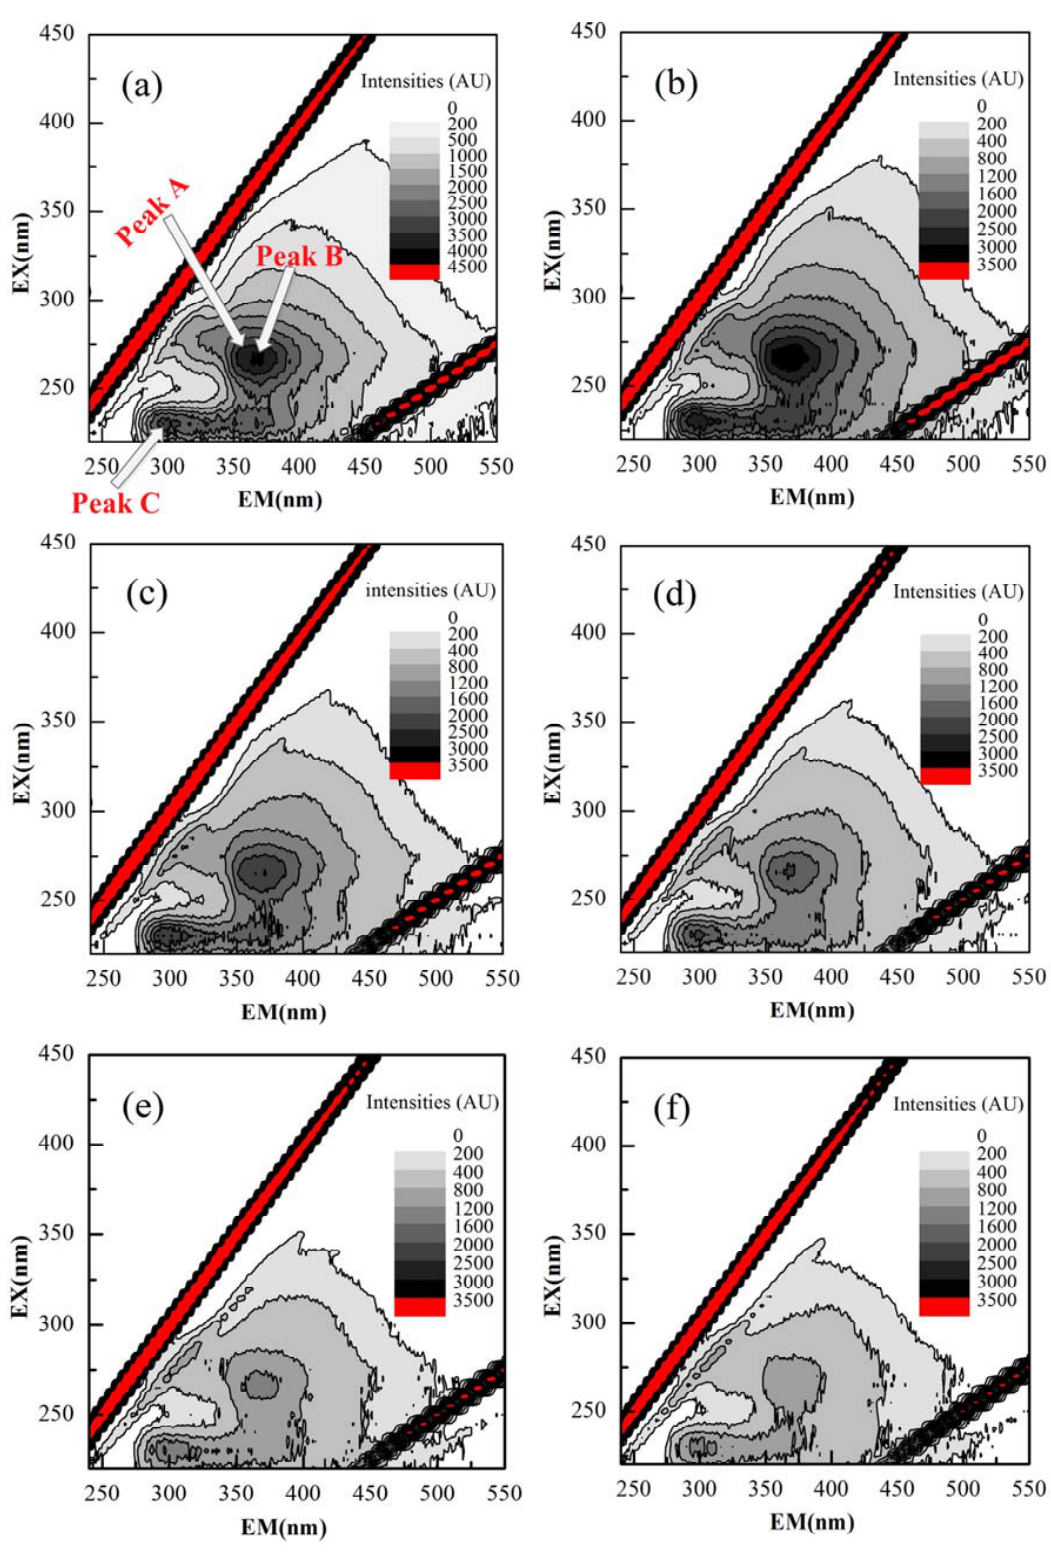
Figure 5. Excitation-emission matrix (EEM) fluorescence spectra of EPS at ozonation time of: ( a ) 0 h; ( b ) 1 h; ( c ) 2 h; ( d ) 4 h; ( e ) 6 h; ( f ) 12 h (Peaks A & B: Soluble microbial by-products, Peak C: Aromatic protein (tryptophan)).